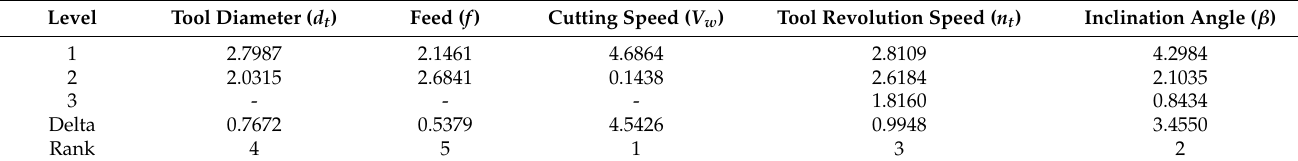
(delta = 0.9948), ranked 4 (delta = 0.7672), and ranked 5 (delta = 0.5379), respectively. Table 4. Response table for Signal-to-Noise Ratios of Ra for each input parameters.